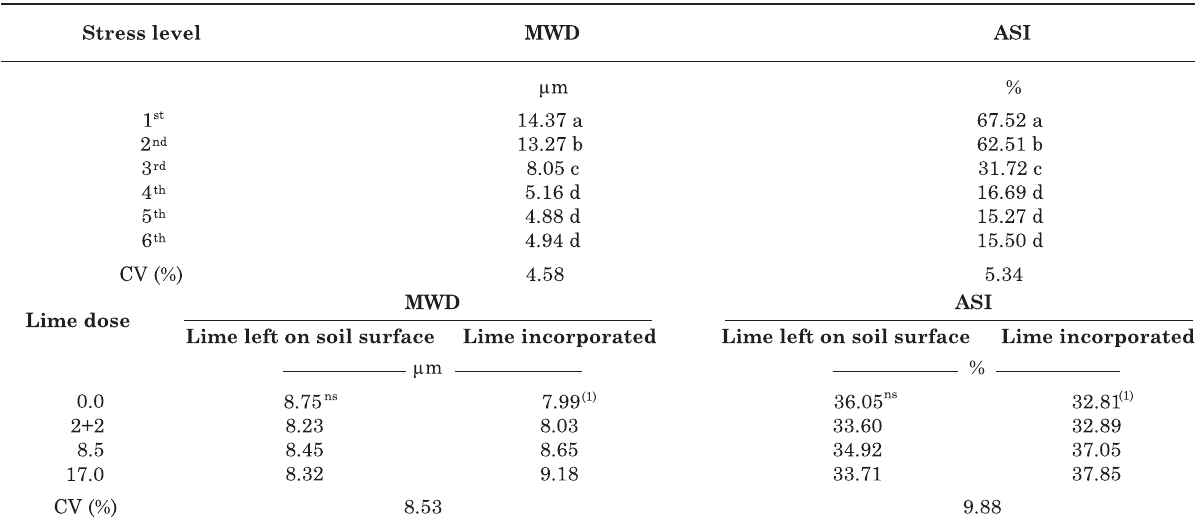
Table 3. Mean values of the weighted diameter (MWD) and the aggregate stability index (ASI) calculated at each stress level. The samples are aggregates between 1 and 2 mm of an Acrisol at 0–0.05 m of depth under liming in different doses and forms of application (lime left on the soil surface and incorporated)